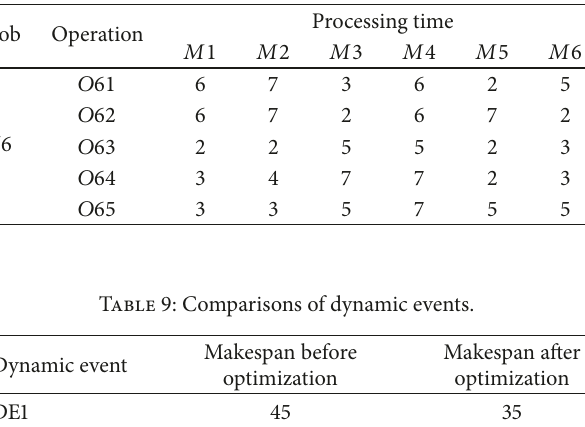
Table 8: Processing information of job 6.